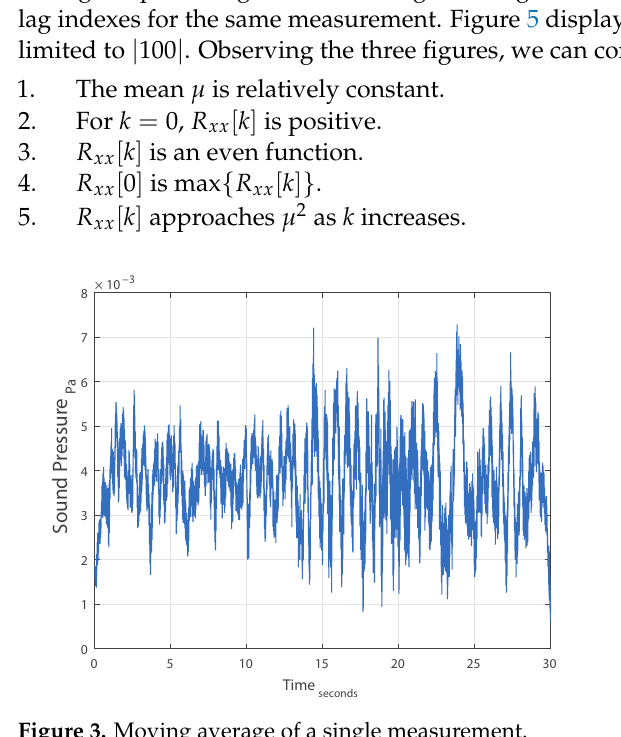
Figure 3. Moving average of a single